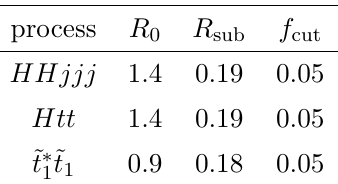
Figure 7. The reconstructed Higgs invariant mass distributions from CNN and MDT methods being tested on the event samples of the HHjjj (left panel), Ht ¯ t (middle panel) and hypothetical SUSY process (right panel). Solid lines represent results with the b -tagger being applied to the Higgs jet candidates.